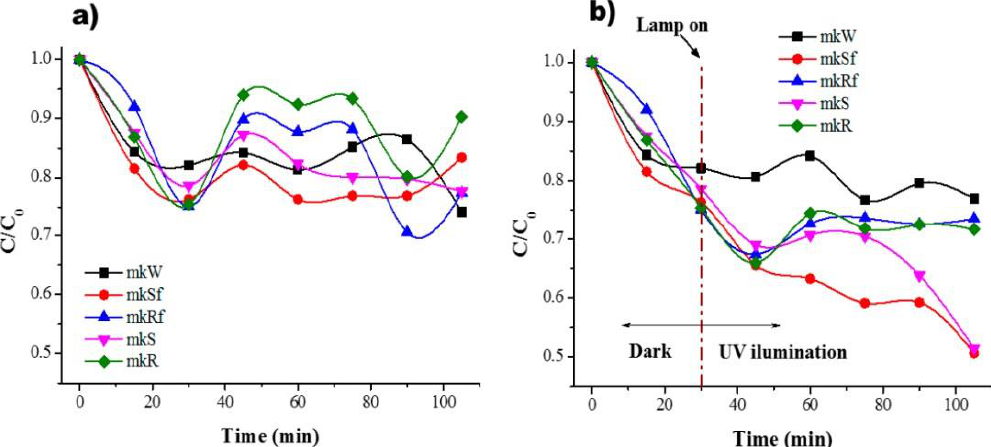
Figure 5. Methylene blue (MB) degradation ( a ) in dark conditions and ( b ) under UV light for the metakaolin paste with zinc oxide (ZnO) nanostructure [113].